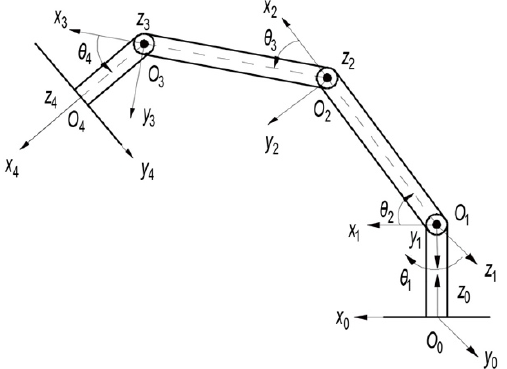
Figure 3. Control diagram of hydraulic manipulator system .